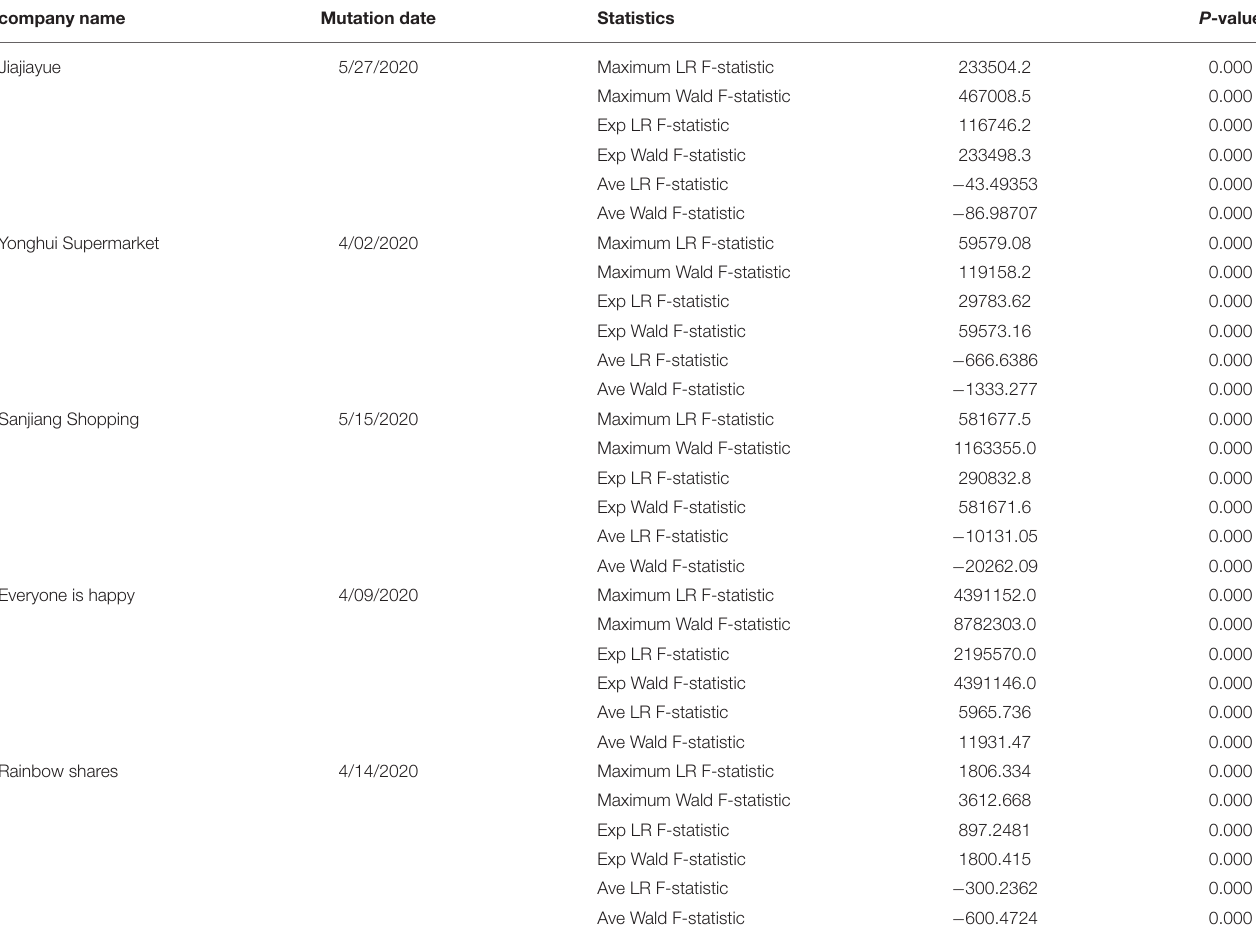
TABLE 1 | The results of Quandt-Andrews test for selected food retailer listed in China’s stock